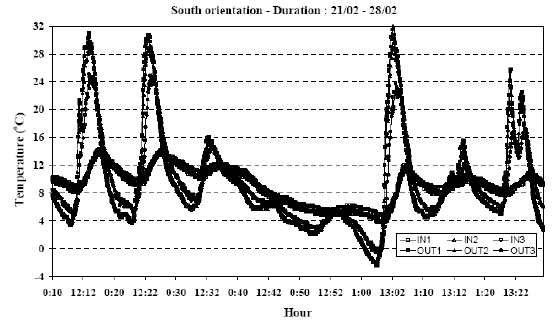
Figure 10. Temperature distribution inside and outside at north wall Summer period .